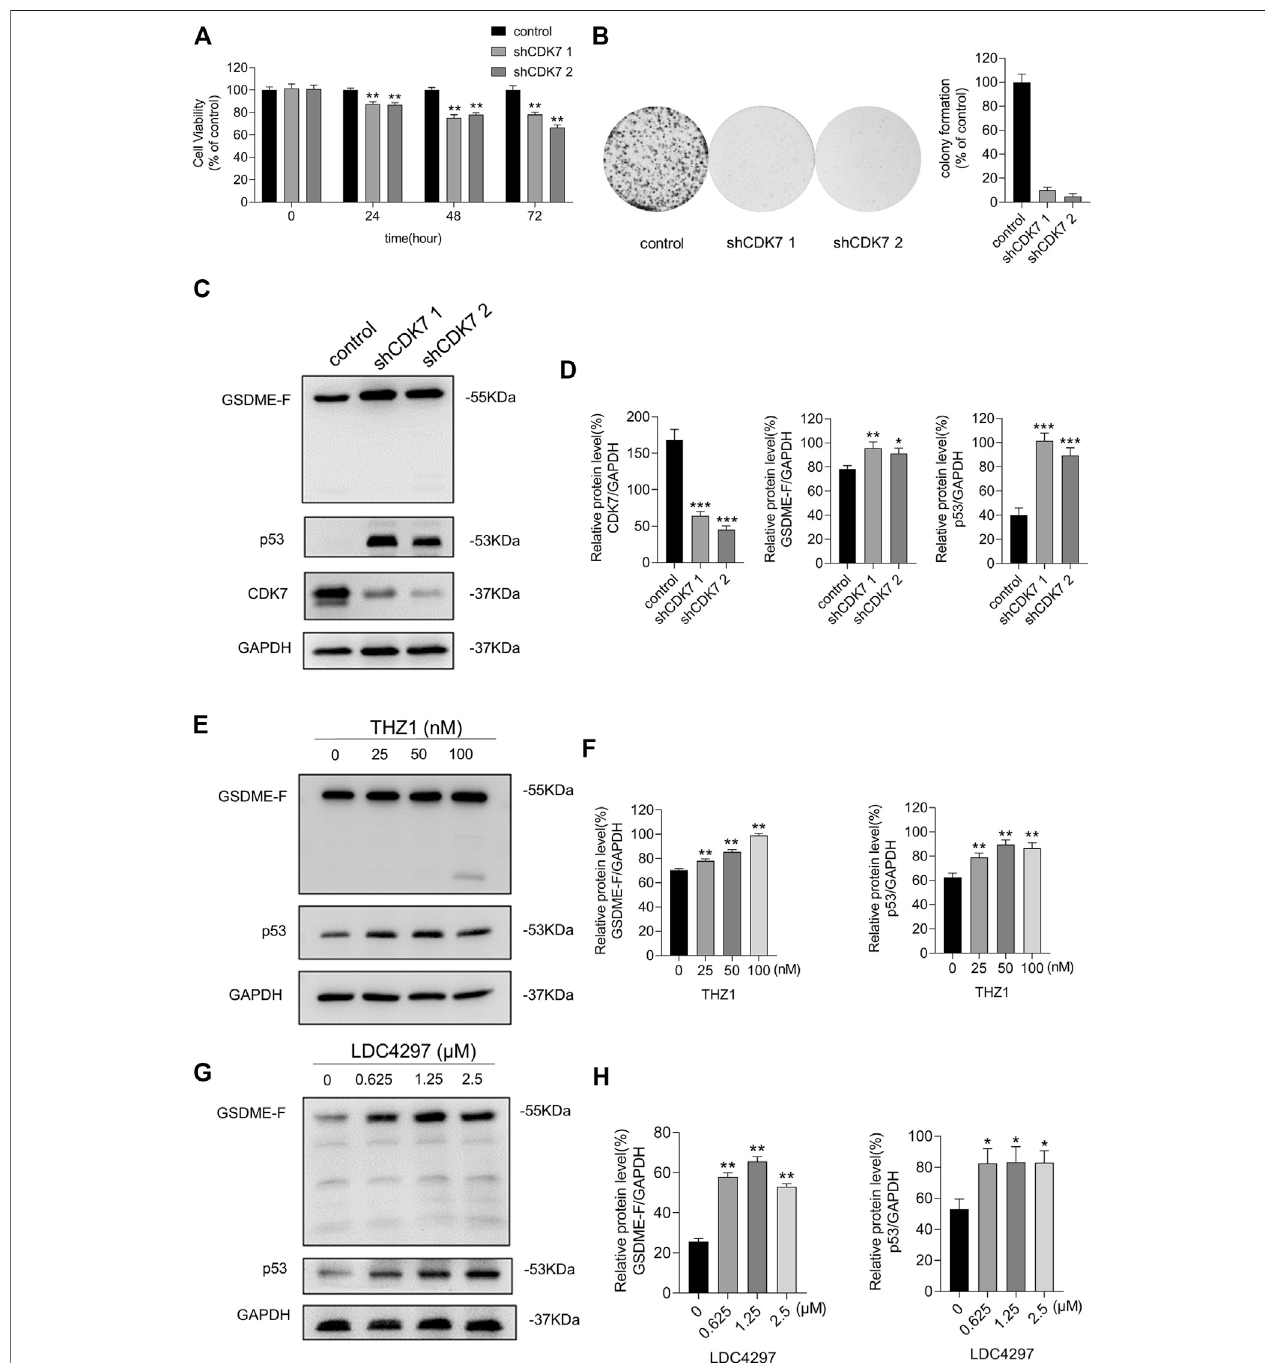
FIGURE 2 | Inhibiting CDK7 upregulated the expression of p53 and GSDME. (A) The CCK8 assay was utilized to measure the viability of MCF-7 cells with CDK7 shRNA at 24, 48, and 72 h. (B) The colony formation assay was meant to test the ability of MCF-7 cells with CDK7 shRNA and control shRNA to form colony spots. (C) The silencing effect of CDK7 shRNA carried by lentiviruses was determined by western blot. (D) Quantity of CDK7, GSDME, and p53 in (C) . (E) Western blot was conductedtodetectthevarietiesofGSDMEandp53proteinlevelsinMCF-7cellswhichweretreatedwithTHZ1for36 h. (F) QuantityofGSDMEandp53in (E) . (G) MCF-7 cells were treated with LDC4297 for 36 h. Western blot was meant for the varieties of GSDME and p53 protein levels in MCF-7 cell detection. (H) Quantity of GSDME and p53 in (G) . Statistically signi fi cant: * p < 0.05; ** p < 0.01.